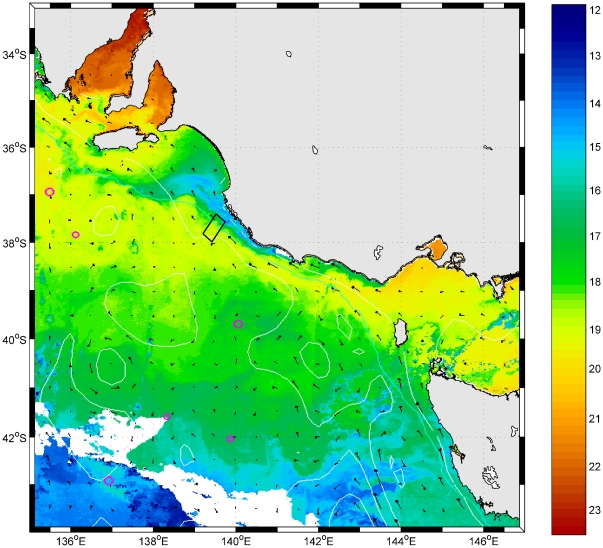
Sea surface temperature (SST °C) map recoded by NOAA satellite during voyage SS02/2008 showing an area of intense upwelling straddling the Bonney Canyon study area (unfilled rectangle).Image courtesy of CSIRO Marine and Atmospheric Research.